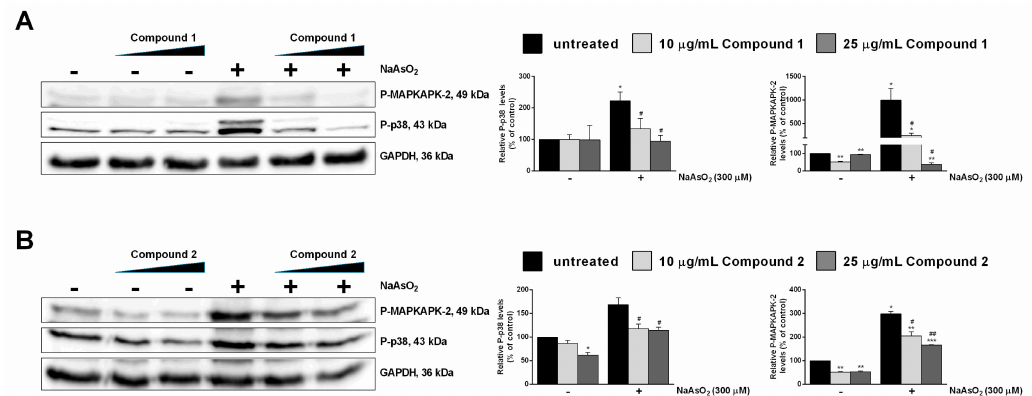
Figure 3. E ff ect of pure compounds on NaAsO 2 -induced mitogen-activated protein kinase (MAPK) cascade in HaCaT cells. Cells were pre-treated with compounds 1 ( A ) and 2 ( B ), as described in Materials and Methods, and Western blots were performed. The phosphorylation levels of MAPKAPK-2 ( A , B , upper panel) and p38 ( A , B , middle panel) are reported. Glyceraldehyde 3-phosphate dehydrogenase (GAPDH) was used as an internal standard. The relative densitometric analysis is reported. Black bars refer to control cells in the absence ( − ) or in the presence ( + ) of NaAsO 2 ; light grey bars refer to 10 µ g / mL-treated cells; and dark grey bars refer to 25 µ g / mL-treated cells. Data shown are the means ± S.D. of three independent experiments. * indicates p < 0.05, ** indicates p < 0.01, *** indicates p < 0.001, with respect to control cells; # indicates p < 0.05, ## indicates p < 0.01 with respect to NaAsO 2 -treated